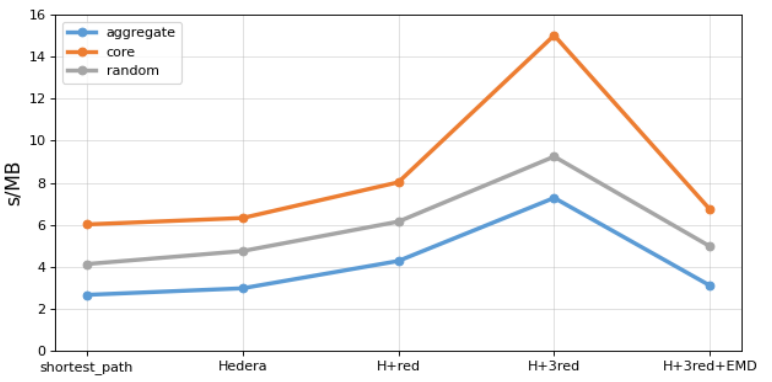
Figure 9. Transmission Time Test of A Fat-tree Data